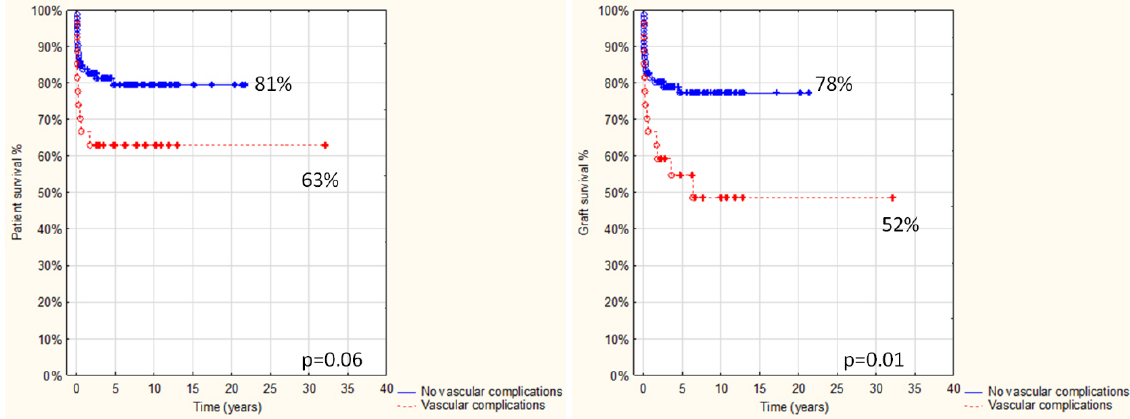
Figure 4. Vascular complications, and patient and graft survival in 142 pts after AB0i LT ( p < 0.05).